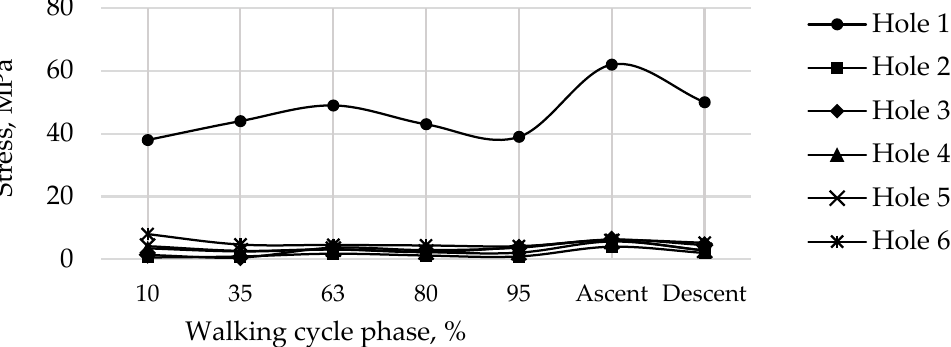
Figure 29. Maximum von Mises stress in the right pelvic bone at the edges of the holes for pretension force of 50 N in different phases of the walking cycle. Table 4. Maximum von Mises stress in the system components with pretension force of 50 N.